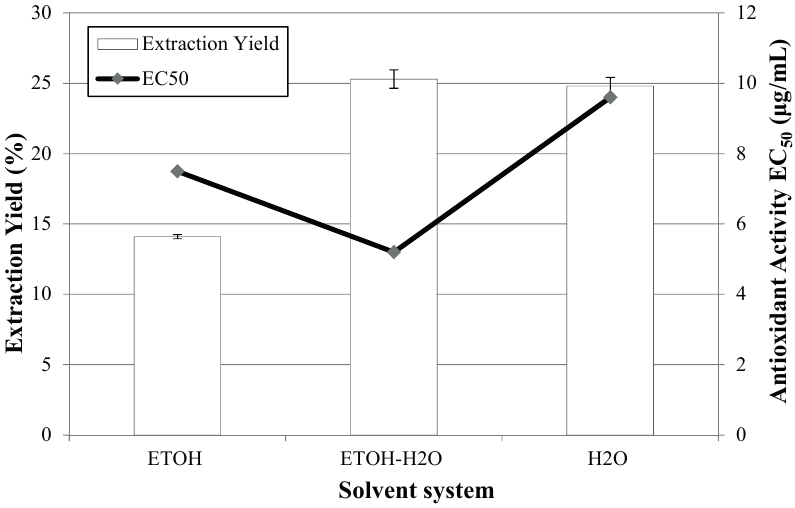
Figure 3. Extraction yields and antioxidant activities, obtained by PLE from Petit Verdot grape pomace using different solvent systems (120 bar, 100 °C, 10 g/min solvent, 3